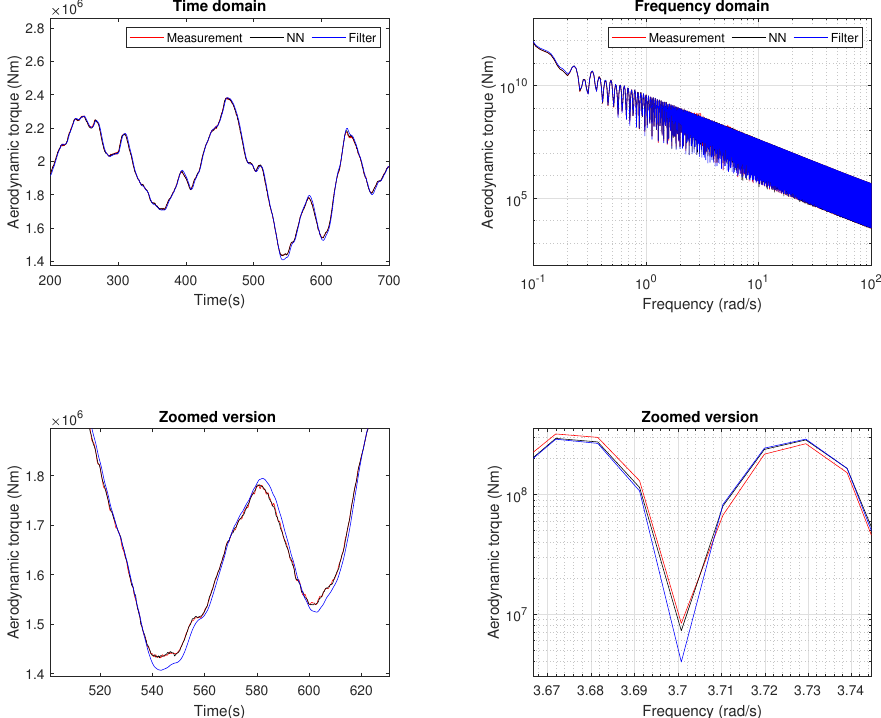
Figure 10. Scenario 3: Aerodynamic torque estimation from Turbine